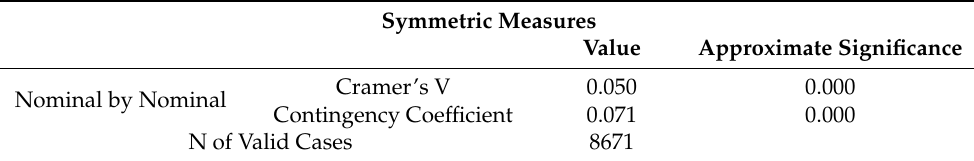
Table 10. Strength of dependence between variables. Source: own research.